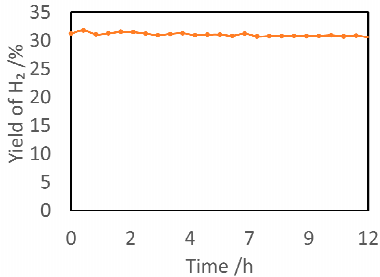
Figure 8. Stability test of Rh/TaON performing photocatalytic dry reforming of methane (DRM). Reproduced from [22] with permission from The Royal Society of Chemistry.